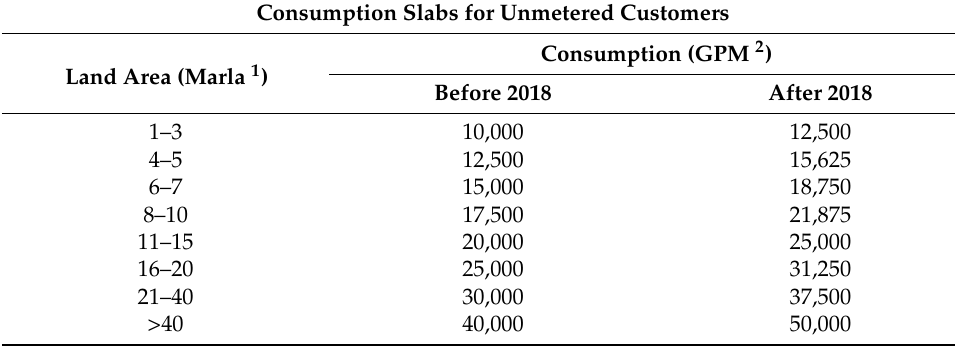
Table 1. Consumption slabs for unmetered customers before and after 2018.